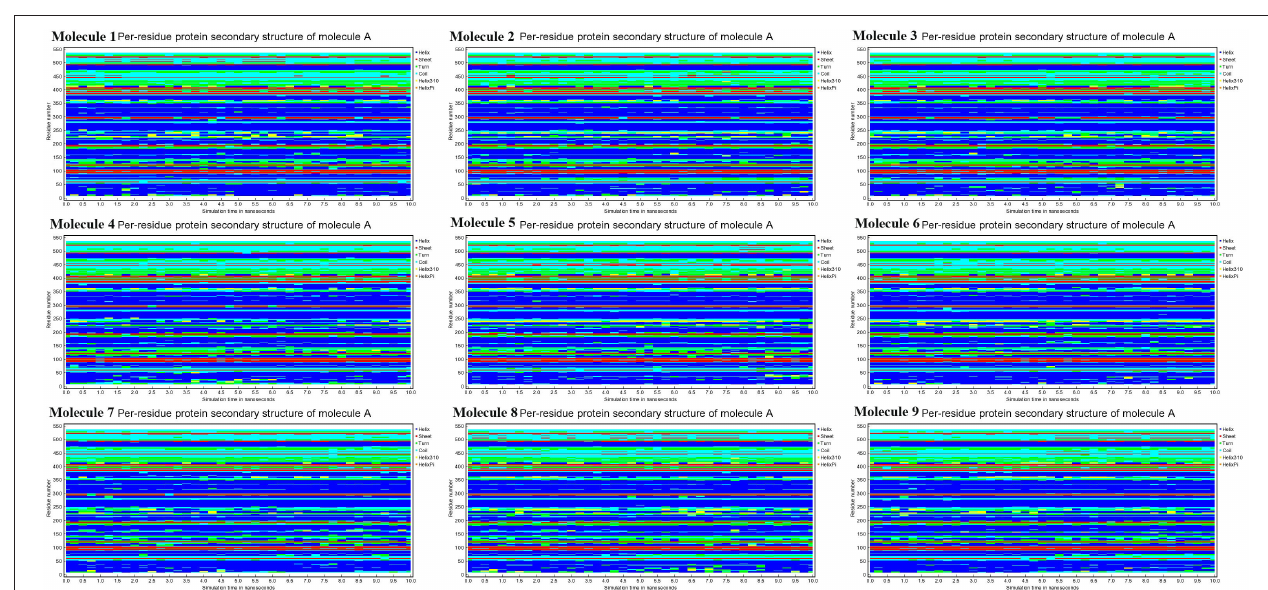
FIGURE 10 | Calculations of Per-residue protein secondary structure of CYP51 and nine molecules as a function of 10 ns simulation time.